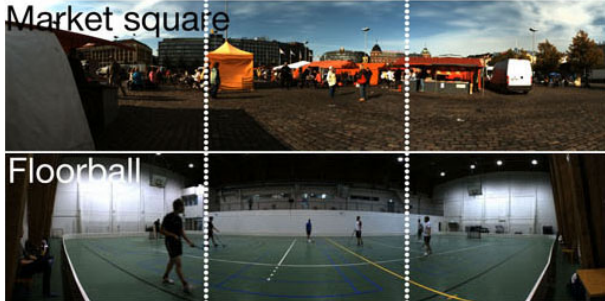
Figure 2 . Market square (upper panel) and Floorball (lower panel) scenes used as the free exploration and target detec- tion stimuli, respectively. Dotted lines denote the corners of the screens.